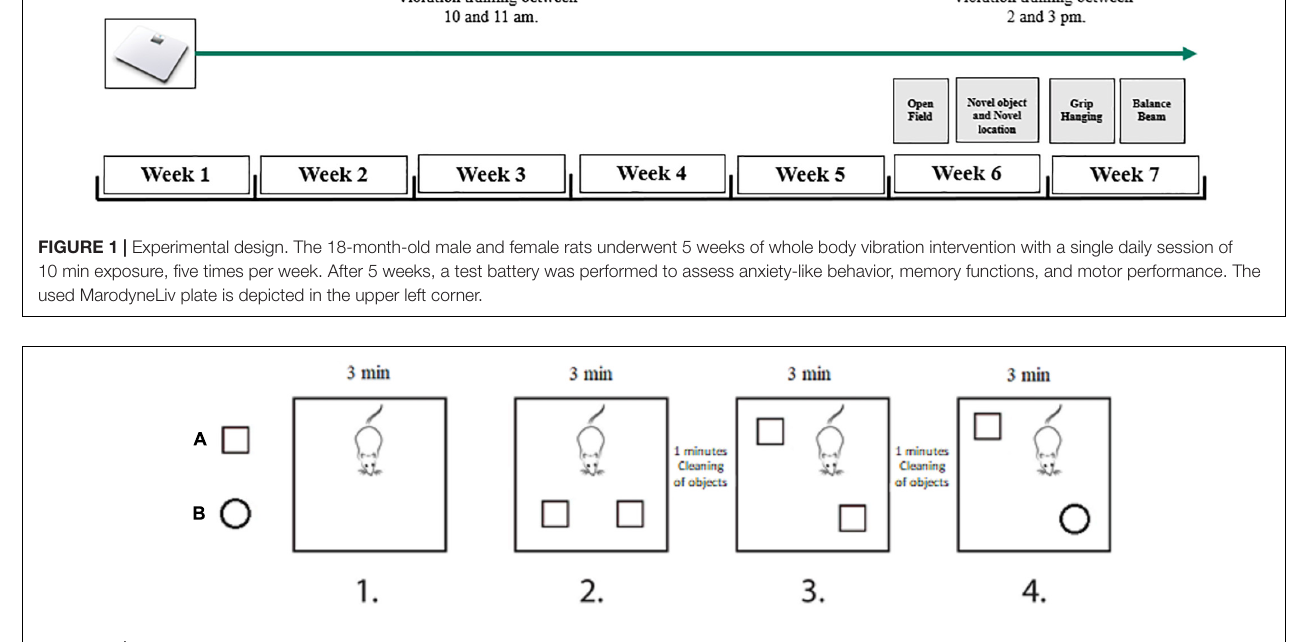
FIGURE 2 | Novel and spatial object recognition test battery was performed to assess spatial and object memory. The test series consisted of four separated phases. Phase 1: rat was placed into the empty test box for 3 min to get familiarized to the test environment. Phase 2: two identical objects were placed into the test box in parallel position, and the rat was familiarized to the objects for 3 min. Phase 3: spatial object recognition: after cleaning, the two same objects were placed back in diagonal position, and the rat was allowed to explore the objects for 3 min. Phase 4: novel object recognition: after cleaning, objects were placed back in the diagonal position; however, one of the familiar objects was replaced by a novel object, and the rat was allowed to explore the objects for 3